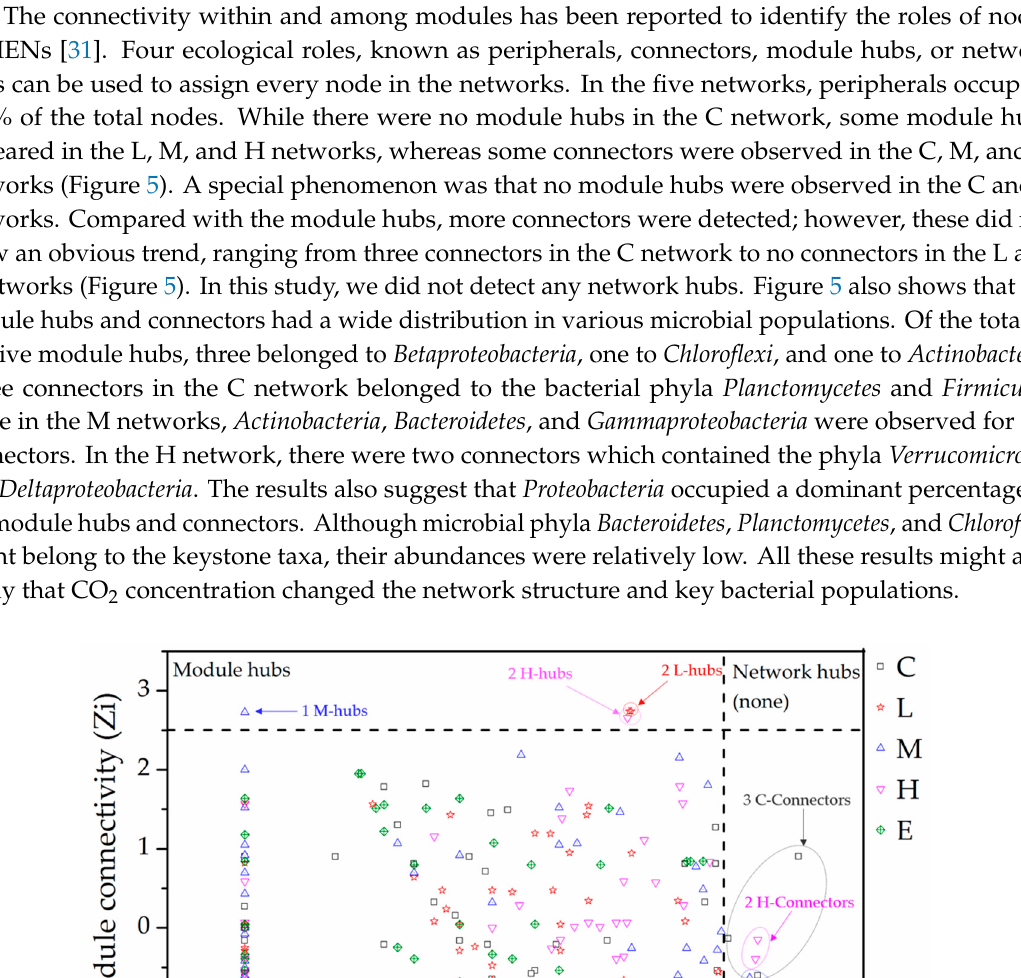
Figure 5. Z-P plot showing the keystone species in the different CO 2 concentration networks. Different symbols with special colors represent different networks showing as follows: black squares for control, red stars for the low CO 2 concentration, blue up-triangles for medium CO 2 concentration, rose red down-triangles for high CO 2 concentration and green diamonds for the extreme CO 2 concentration. The module hubs and connectors are labeled with phylogenetic affiliations. (C, control; L, low CO 2 concentration; M, medium CO 2 concentration; H, high CO 2 concentration; E, extreme CO 2 concentration).